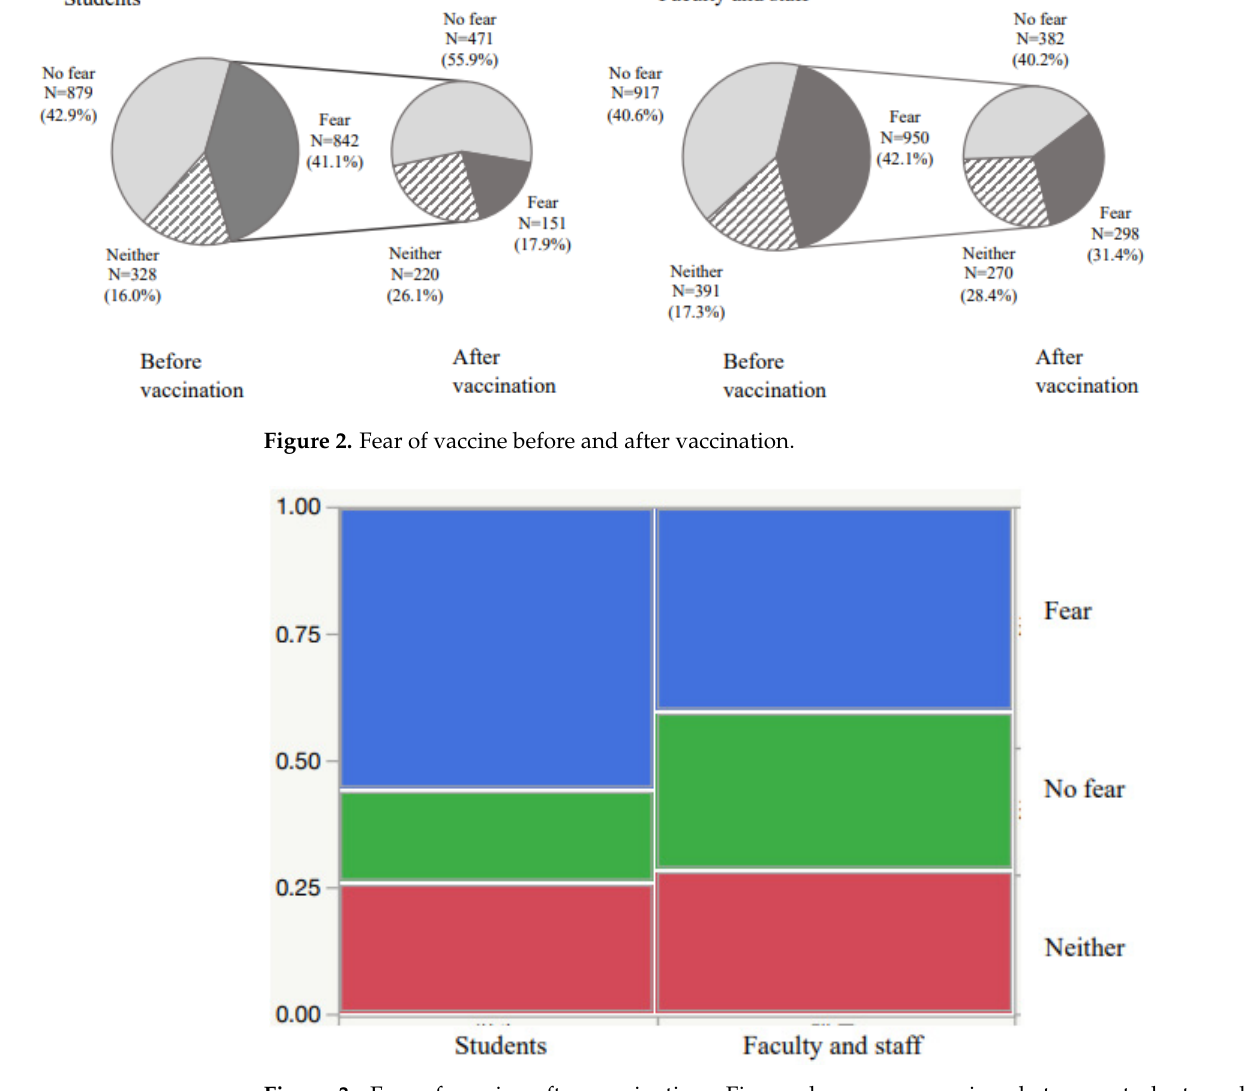
Figure 3. Fear of vaccine after vaccination. Figure shows a comparison between students and faculty staff regarding their fear of vaccine after vaccination. Significantly more students had no fear after vaccination.